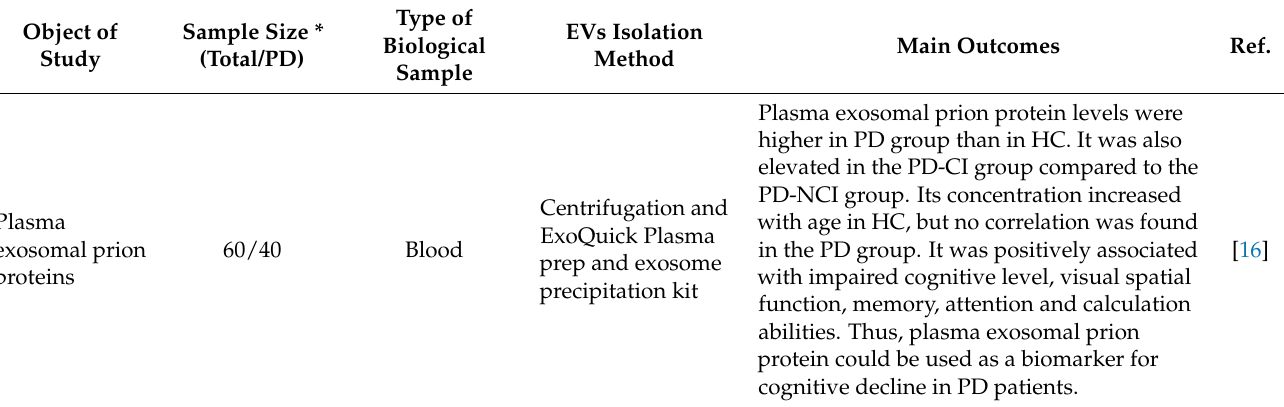
Table 1. Summary of studies analyzed and their main